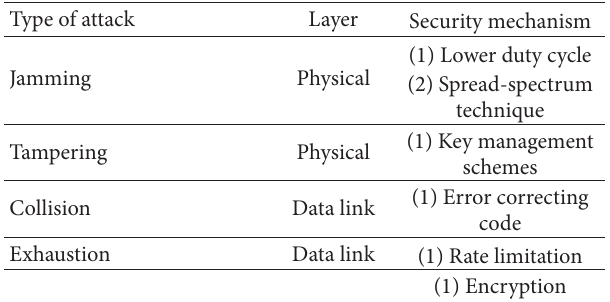
Table 1: Several attacks and their corresponding security mecha- nisms in